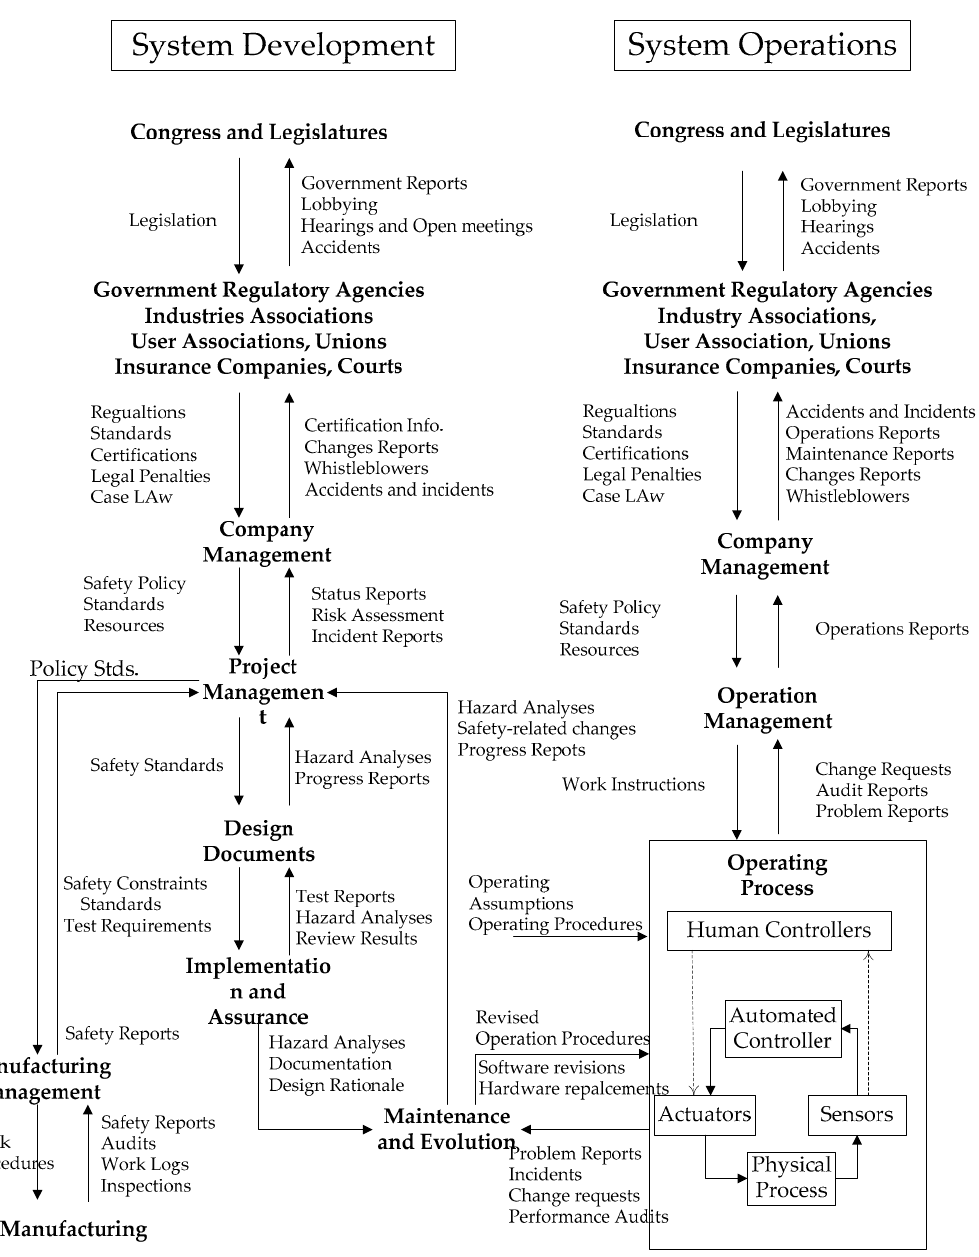
Figure 3. General socio-technical system control structure from the system-theoretic accident model and process (STAMP) [15]. Reproduced with permission from [15], Elsevier,